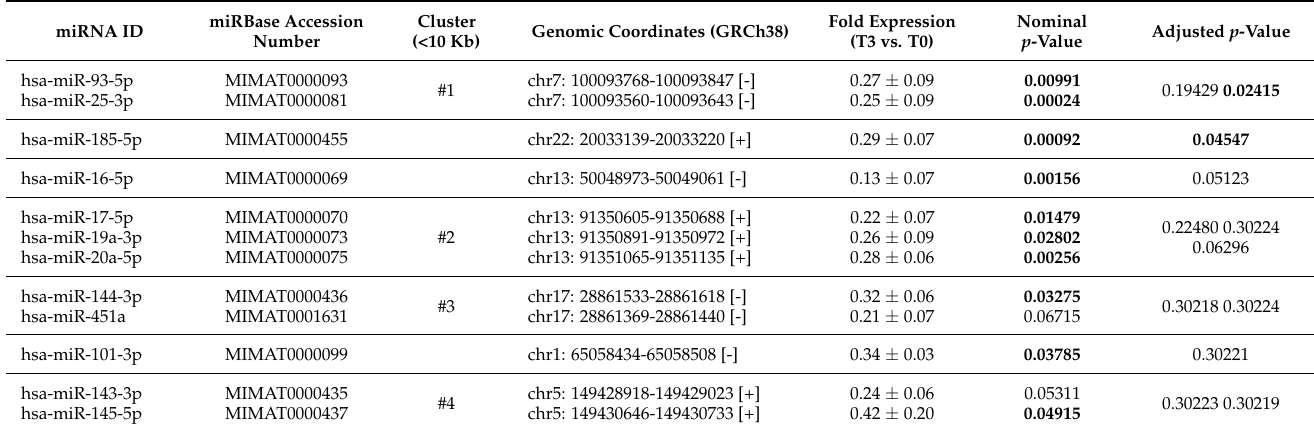
Table 2. Serum miRNAs differentially expressed in patients after treatment (T3) compared to base- lines (T0). Bold characters indicate significant p -values both at a nominal level and adjusted for mul- tiple testing. Differences between two groups (T3 vs. T0) were analyzed by paired two-tailed t -test, followed by Benjamini–Hochberg correction.